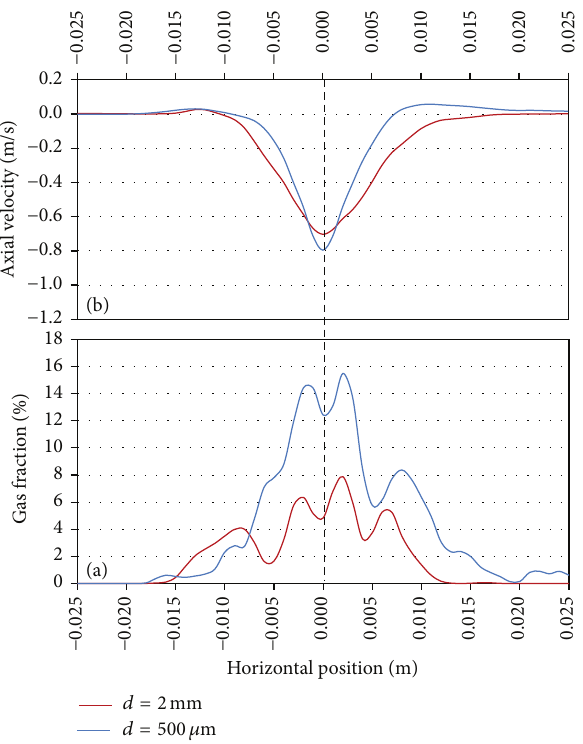
Figure 5: Plots of (a) gas fraction and (b) axial velocity (phase fraction averaged) along a horizontal line at the liquid midheight for a the two bubble diameters ( 𝑑 = 500 𝜇 m and 𝑑 = 2mm) with interface sharpening activated ( 𝐶 𝛼 = 1 ). Vertical dashed line shows the jet axis.